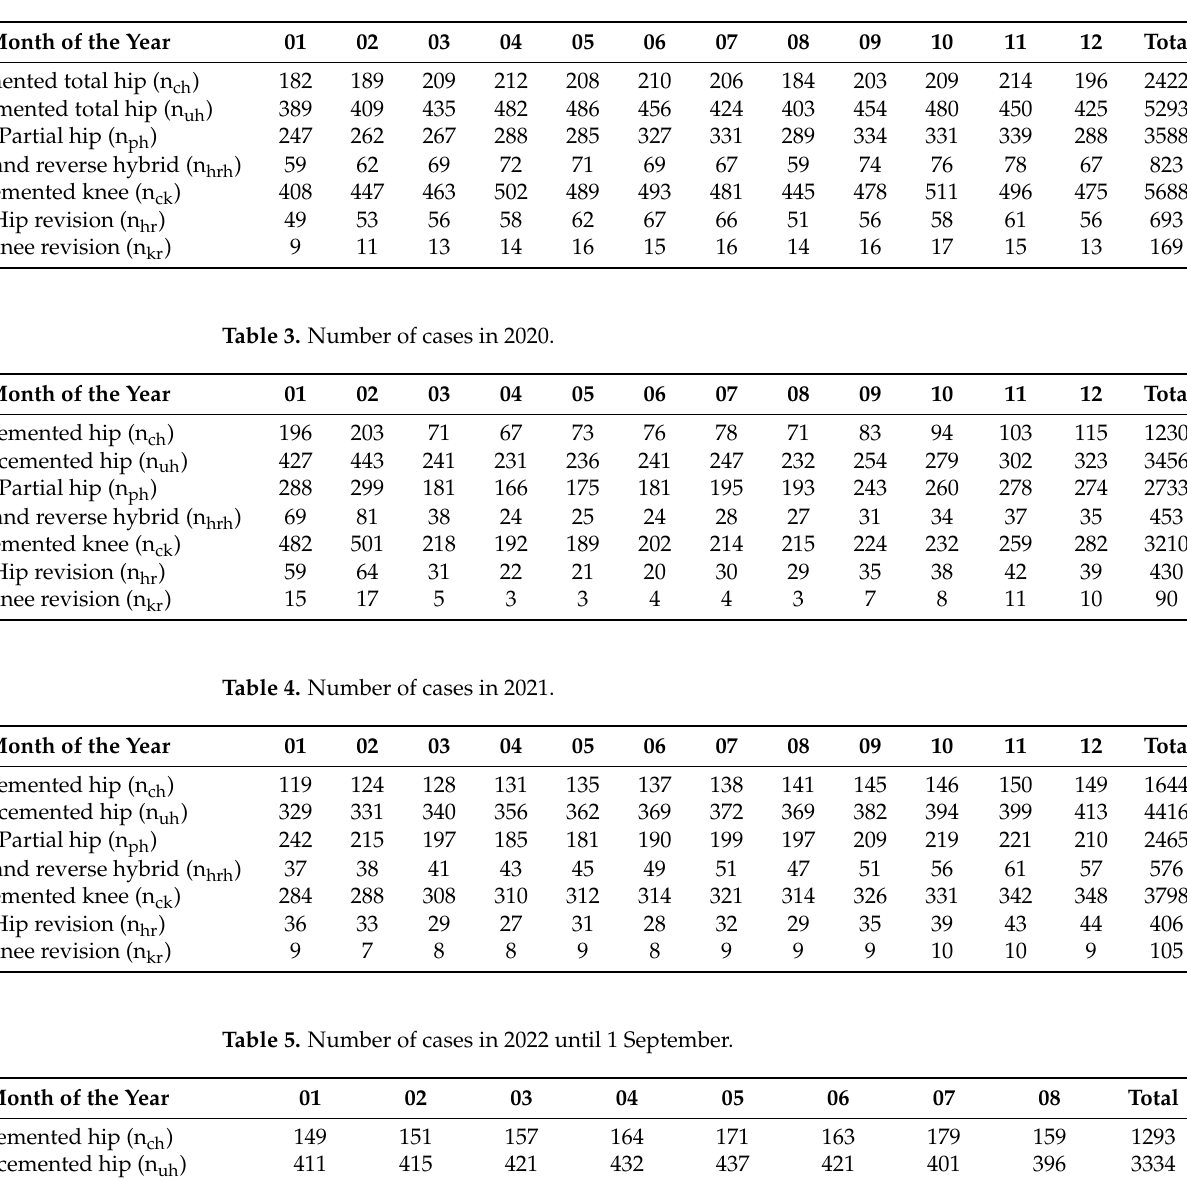
Table 2. Number of cases in 2019.